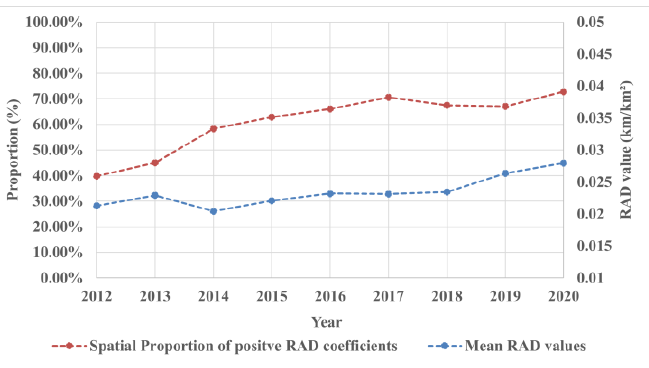
Figure 11. Temporal trends of mean RAD values and spatial proportion of positive RAD coefficients.